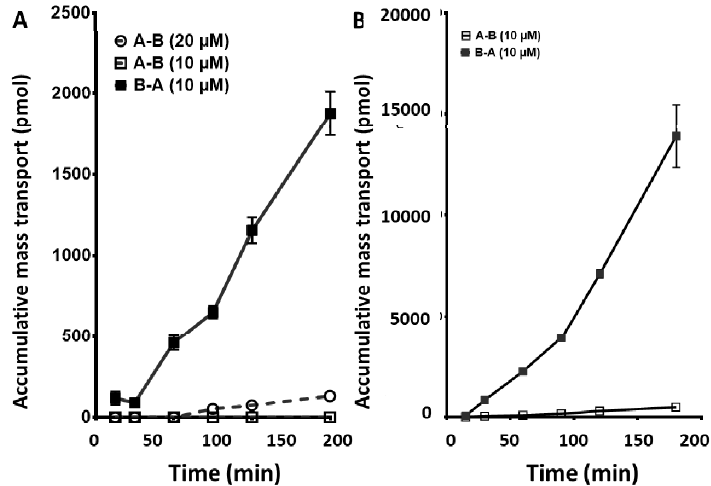
Figure 5. Cumulative mass transport of crizotinib ( A ) and dasatinib ( B ) across a CaCo2 monolayer. Crizotinib was tested at 10 and 20 µ M. At 10 µ M, crizotinib no A–B transport was detected, most likely due to the sensitivity of the assay used for determination of the concentration. At a higher concentration (20 µ M), minimal A–B transport was observed but was still 20-fold lower than mass transport observed in the B–A direction at the 10 µ M dose level. Dasatinib was tested at 10 µ M. All values are the mean ± standard error of the mean 3 or more replicates. When not visible, the error bars are within the size of the marker.